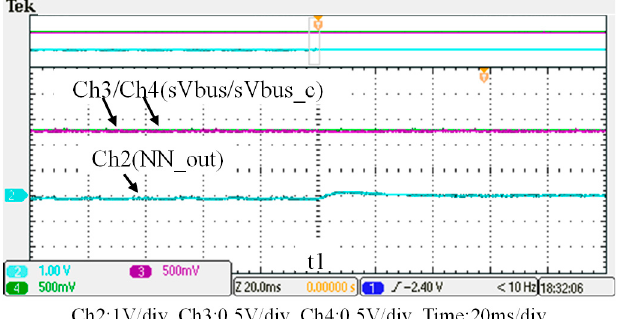
Figure 24. The shunt APF dq-axis current commands and feedbacks (t 0 –t 2 ).